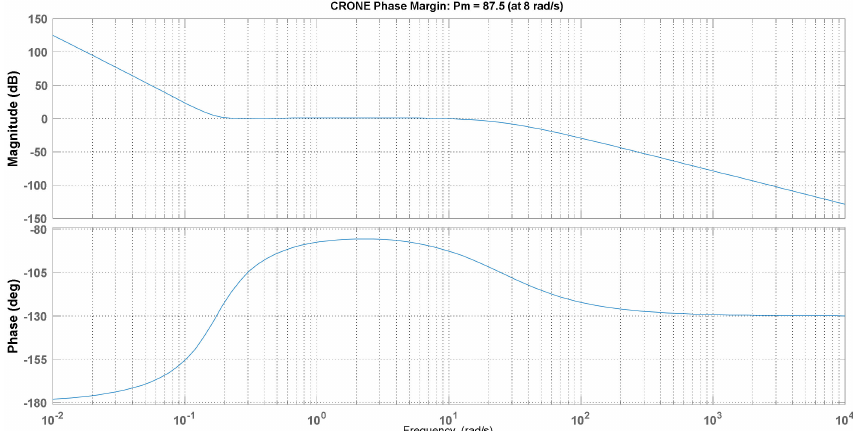
Figure 6. Bode plot of the controlled open-loop.